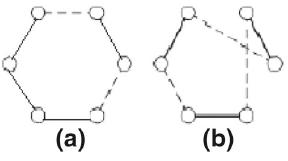
Fig. 5 All combinations of sub_toures for k = 2